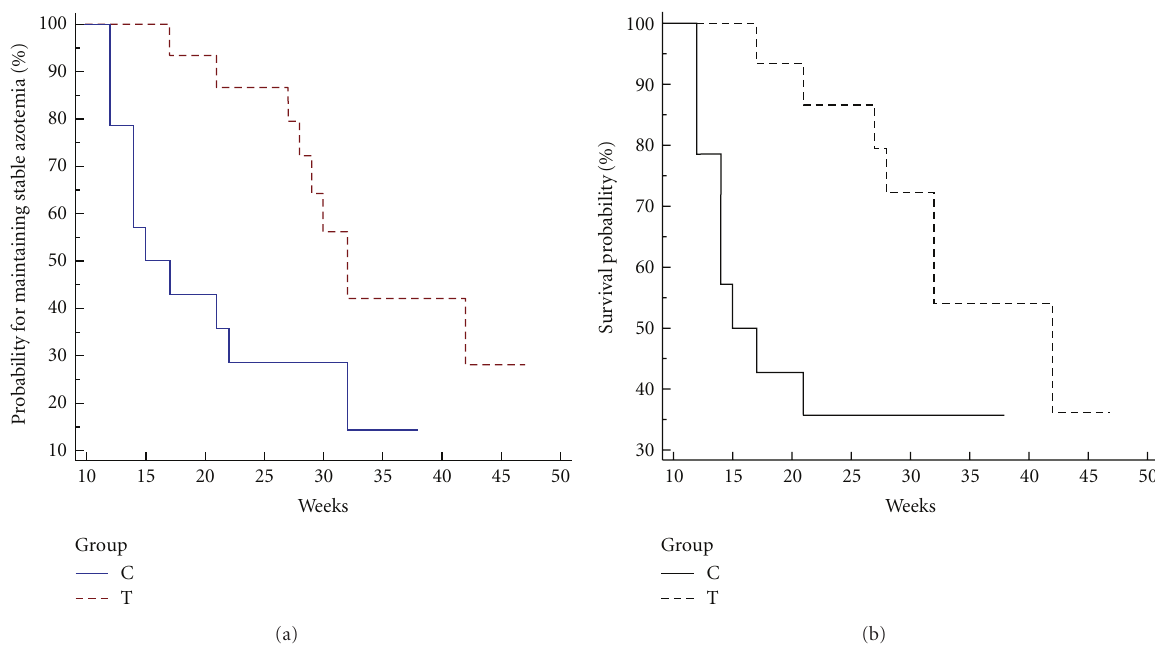
(a) Figure 1: (a) Kaplan-Meier evaluating the probability of maintaining stable level of serum creatinine in treatment group B and in placebo group A. Legend: C: placebo control group A; T: treatment group B. (b) Survival curves (death from renal causes) in CKD dogs in IRIS stages 2, 3, and 4 in treatment group B and in placebo control group A. Legend: C: placebo control group A; T: treatment group B.